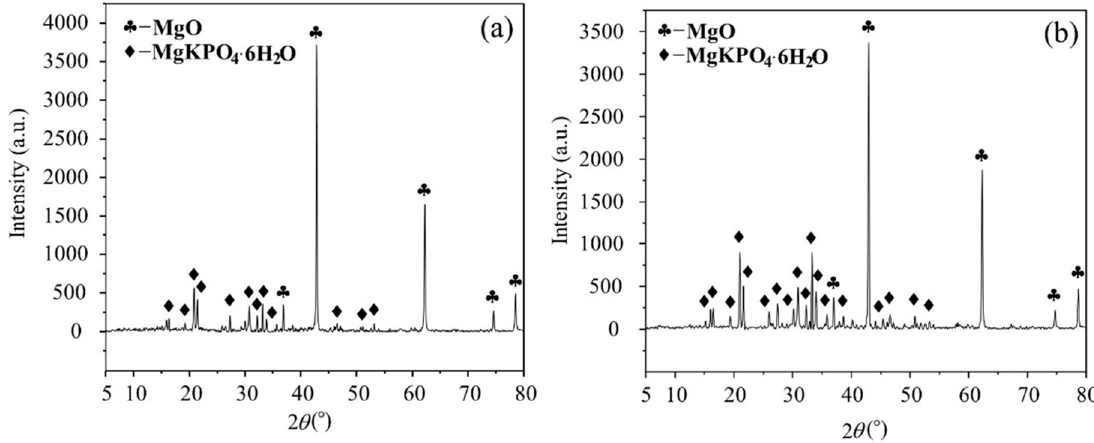
Figure 17. X-ray Diffraction (XRD) intensity for specimens without CF: ( a ) T7; ( b ) T28.